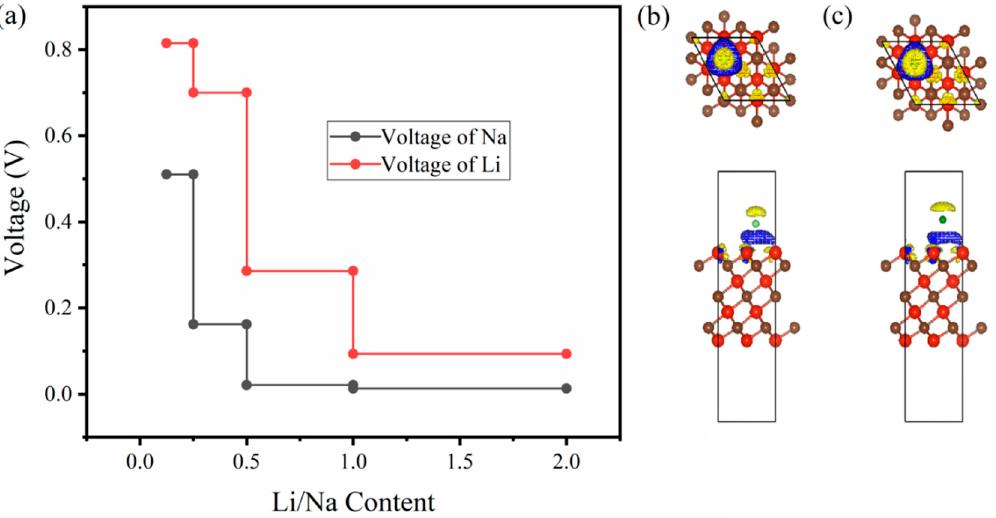
Figure 4. ( a ) Voltage plots of Li/Na. Charge density difference with front and side views of ( b ) Li adsorbed on site-1 and ( c ) Na loaded on site-1. The yellow color in ( b , c ) represents the electron deficit, blue is the accumulated electrons, red is V, and brown is C.